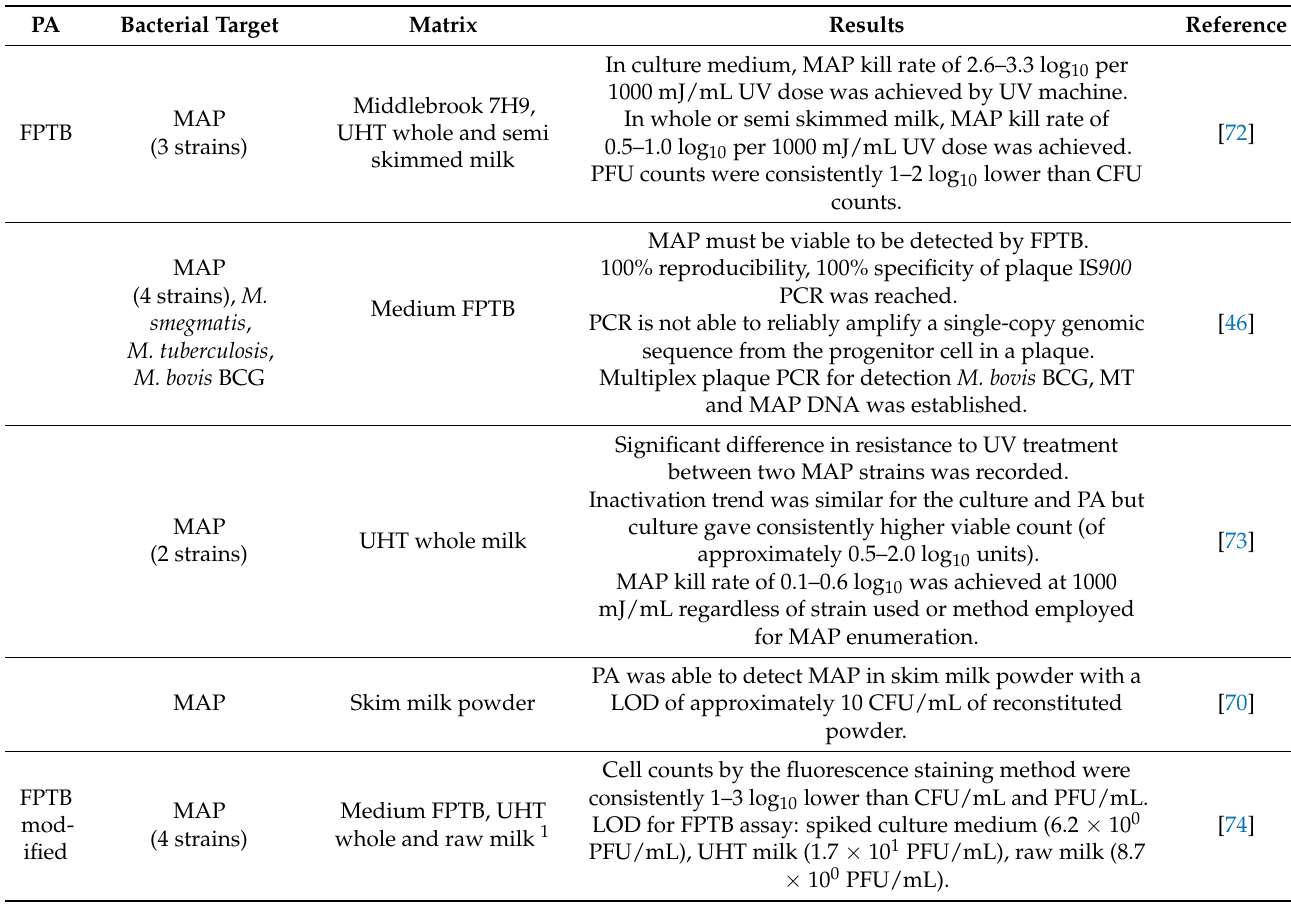
Table 4. Optimization and evaluation of phage amplification assay for the detection of mycobacteria significant in veterinary medicine using artificial contamination of